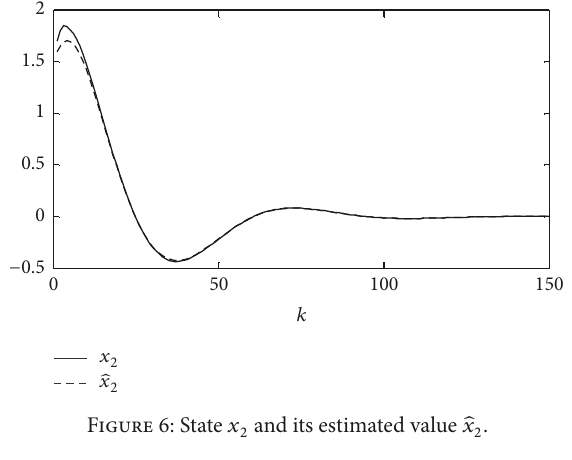
Figure 6: State 𝑥 2 and its estimated value ̂𝑥 2